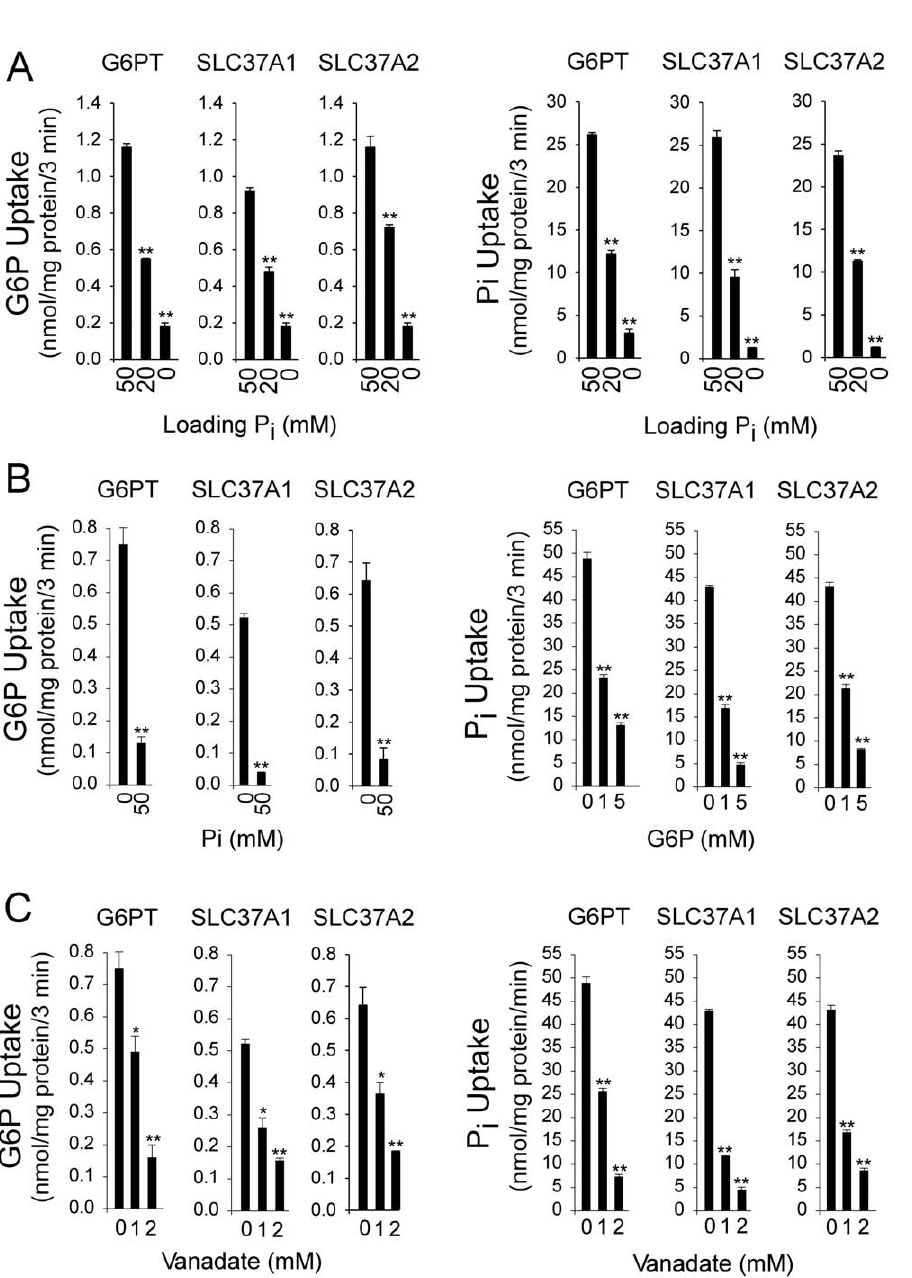
Figure 3. Effects of P i loading, external G6P, P i and vanadate on antiporter activity of SLC37 members. Proteoliposomes were reconstituted from detergent solubilized microsomal membrane extracts isolated from Ad-SLC37A1-5Flag, Ad-SLC37A2-5Flag, or Ad-G6PT infected COS-1 cells as described under Materials and Methods. Results shown are from three independent experiments, each point determined in triplicate. (A) Effects of P i -loading on G6P or P i uptake activity of SLC37 proteoliposomes. The concentrations of P i loaded were 50 mM, 20 mM, and 0 mM (MOPS). (B) Inhibition of G6P uptake in 50 mM P i -loaded SLC37 proteoliposomes by external P i or inhibition of P i uptake in 50 mM P i -loaded SLC37 proteoliposomes by external G6P. (C) Effects of vanadate on G6P and P i uptake activities of SLC37 proteoliposomes. Data are presented as the mean 6 SEM. * p , 0.05; ** p , 0.005.